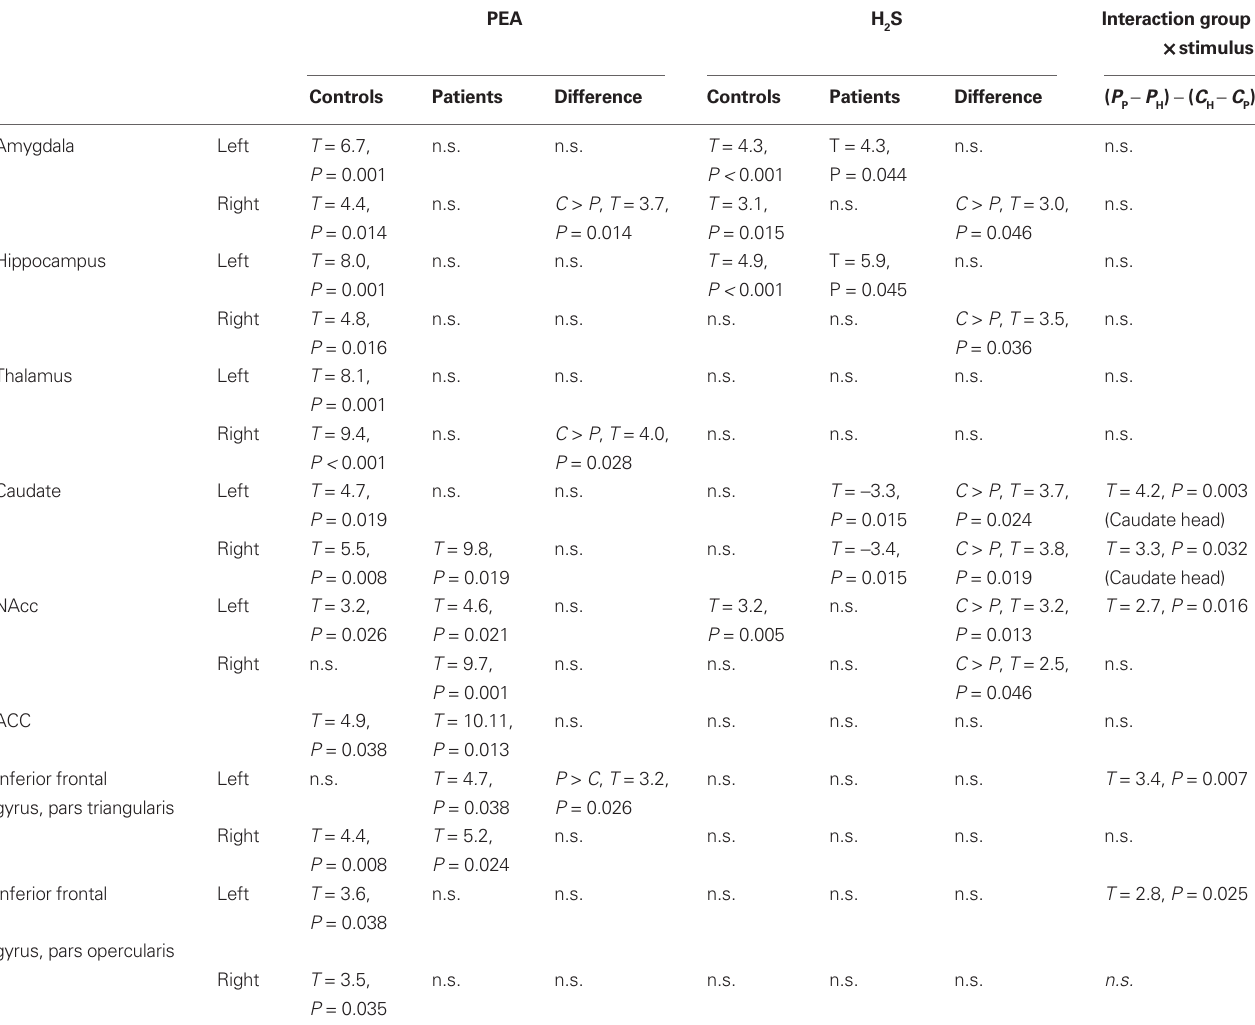
Table 2 | region of interest